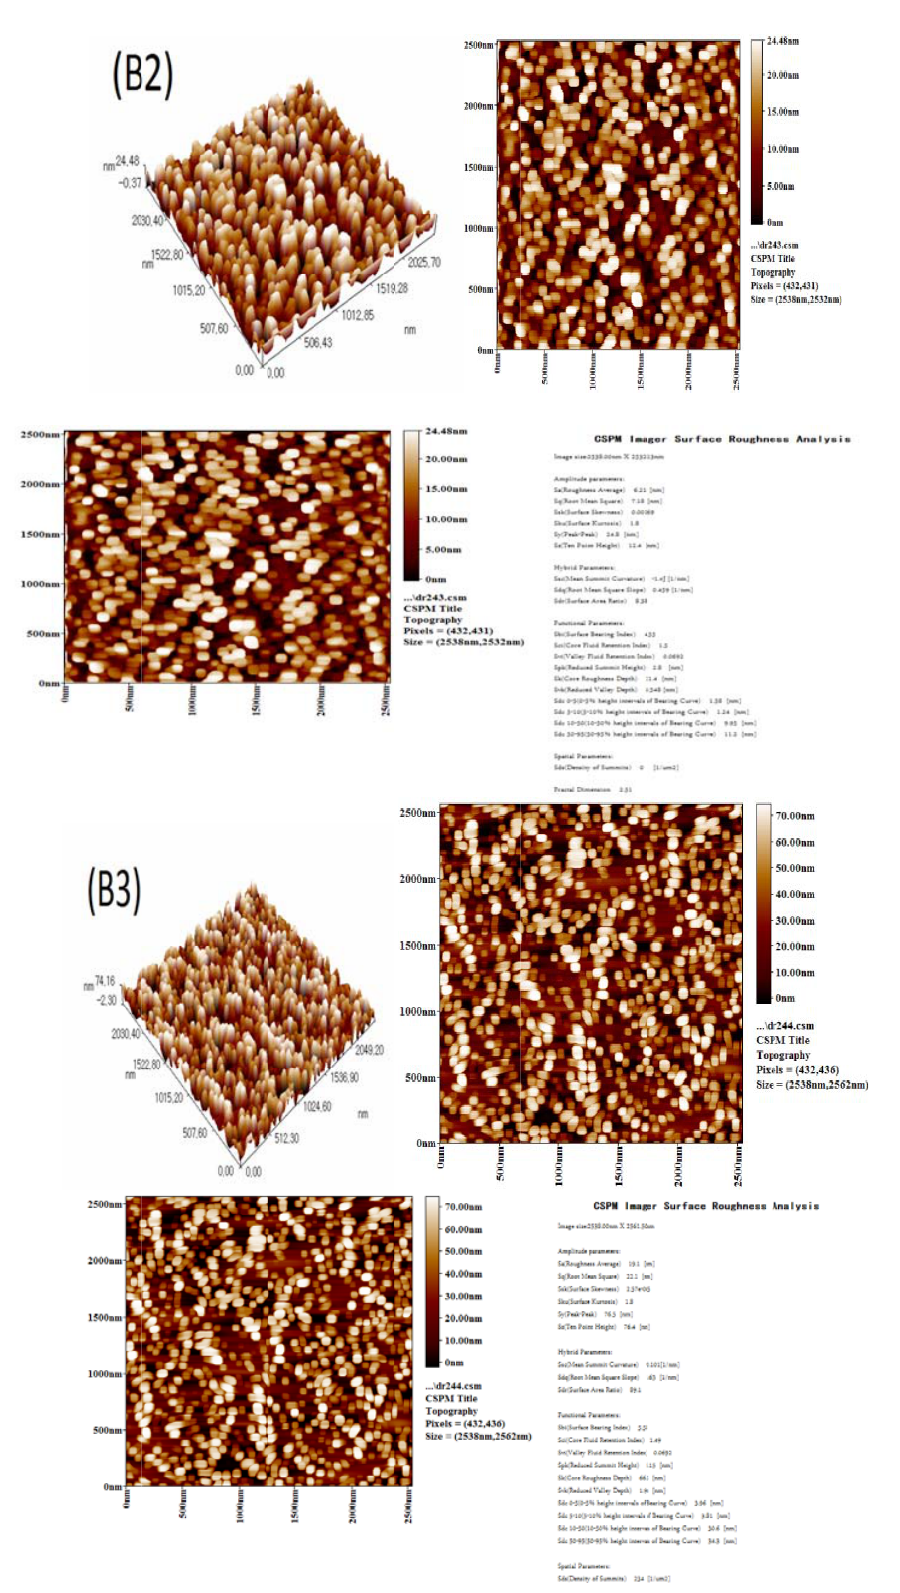
4: The 2D and 3D AF FM images temp peratures (3 00, 400 and 500) °C.